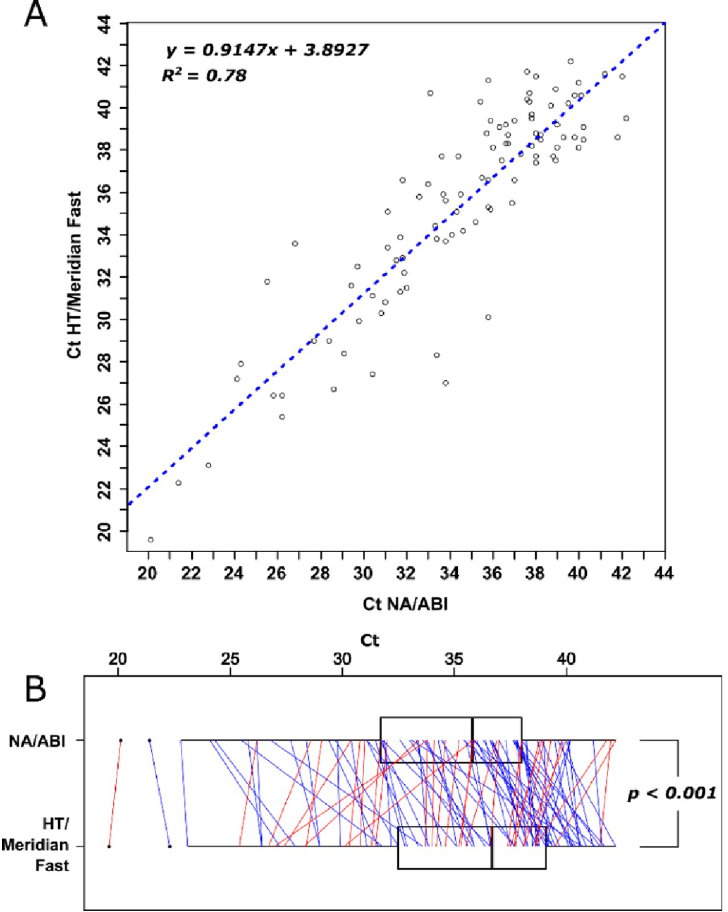
Fig 1. Correlation between NA extraction-based and heat treatment-based detection of SARS-CoV-2. A) Correlation of Ct values from NA/RT-qPCR (NA/ABI) and heat treatment/RT-qPCR (HT/Meridian Fast 1-Step). The Ct values obtained for the samples positive for SARS-CoV-2 using both methods (S6 Table) were plotted against each other. B) Comparison of Ct values in paired samples that were positive in both NA/ABI and Heat-treatment/RT-qPCR. The paired samples are individually plotted as red and blue lines if Heat-treatment/RT-qPCR Ct was earlier or later than NA/RT-qPCR, respectively. Paired t-test, t = -4.0787, df = 100, p = 0.00009.